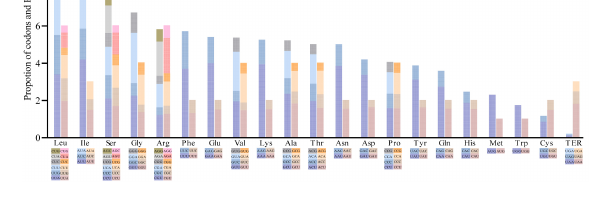
FIGURE 5 Codon content of 20 amino acids and termination codons in protein-coding genes of Cerasus plastomes. The left columns of the histogram present codon usage and the right columns denote the relative synonymous codon usage (RSCU) values. Colors correspond to codons listed underneath the